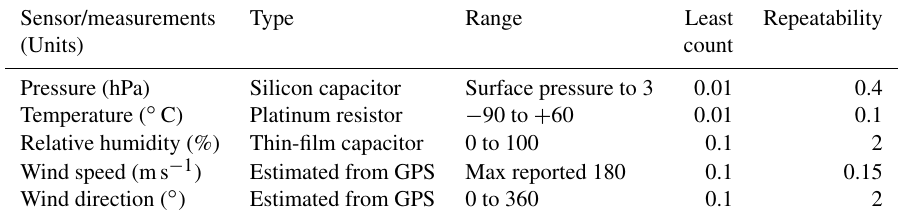
Table 1. Details about sensors used in the RD-41 and RS-41 sondes are provided. Repeatability is the standard deviation of differences in twin soundings. The values for the sensors are obtained from Vaisala (2020a), and values for wind measurements estimated from GPS are obtained from Vaisala (2020b). All numbers are provided in terms of absolute units, correspondingly in the first column.